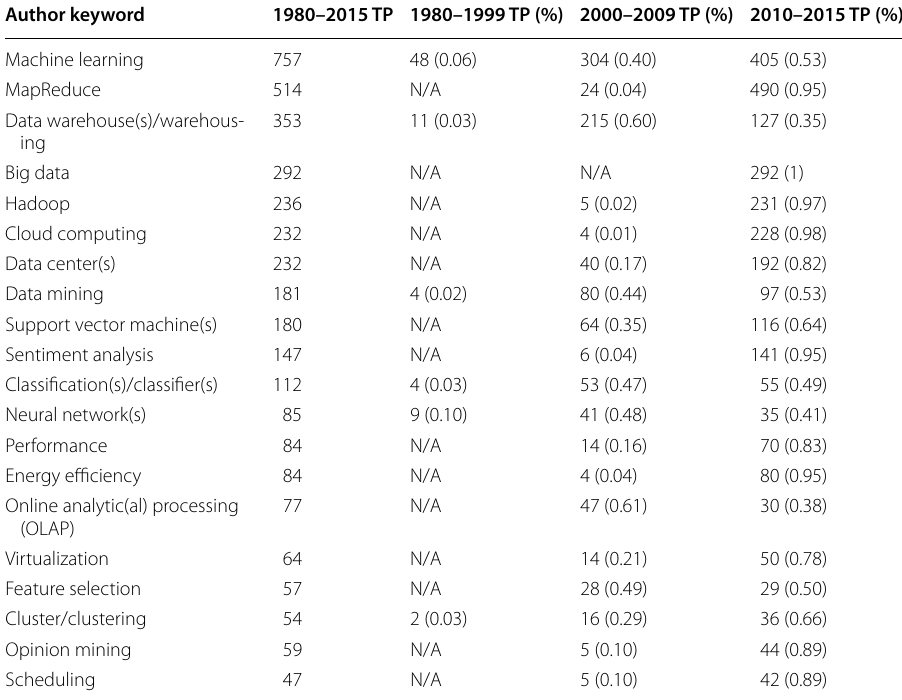
TP: total number of publications, %: the percentage of keywords over total number of records